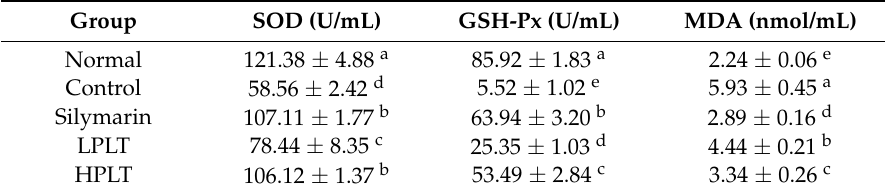
Table 6. Serum superoxide dismutase (SOD), glutathione peroxidase (GSH-Px), and malondialdehyde (MDA) levels in experimental mice with CCl 4 -induced hepatic